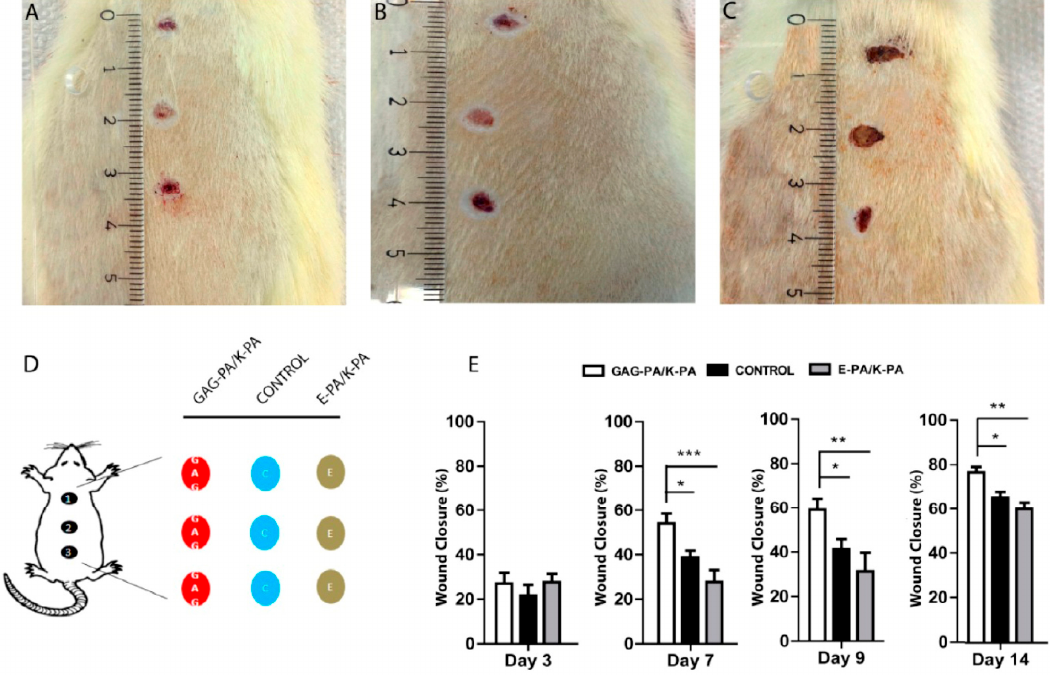
Figure 7. Wound closure in diabetic rats for subjects treated with ( A ) GAG (glycosaminoglycan)-PA (Peptide amphiphiles)/K-PA (also known as positively charged heparin mimetic PAs), ( B ) PBS control, and ( C ) E-PA (negatively charged heparin mimetic PA)/K-PA. ( D ) shows the schematic diagram for the location of wound on the rats that were treated with GAG-PA/K-PA, PBS and E-PA/K-PA samples. ( E ) Shows the % wound closure studied for 14 days after the treatment. It can be seen that after 14 days of the treatment compared to control. It can be seen that GAG-PA/K-PA bio gel-treated group provided significant wound healing property on 14th day of treatment, compared to the E-PA/K-PA- or PBS-treated control groups (one way ANOVA test with * p < 0.05, ** p < 0.01, *** p < 0.001). Reproduced with permission from [150].